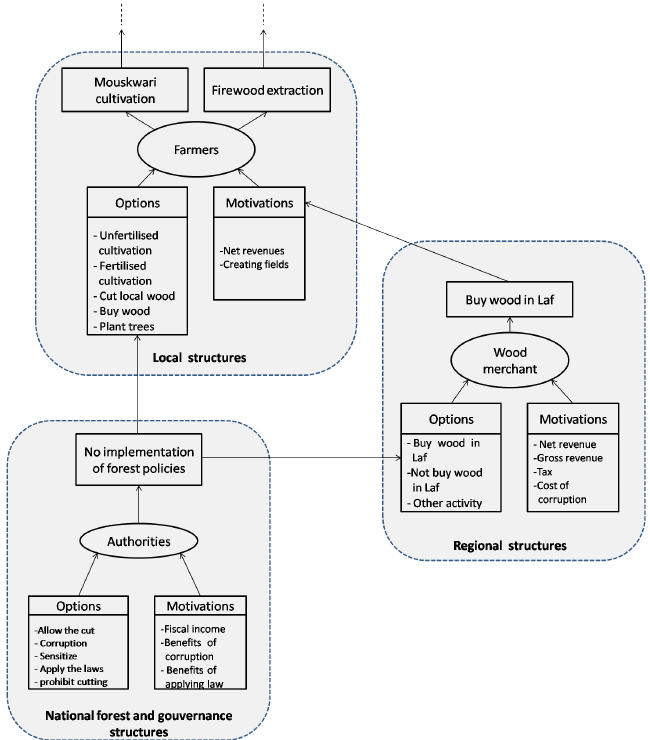
Figure 9. The social causation submodel of the environmental problem in Laf Forest Reserve [72]. This figure shows modelled actors (farmers as primary actor, wood merchant as secondary actor and government as tertiary actor). Options and motivations are depicted as connected to structures (systems) on three scale levels: local, regional,